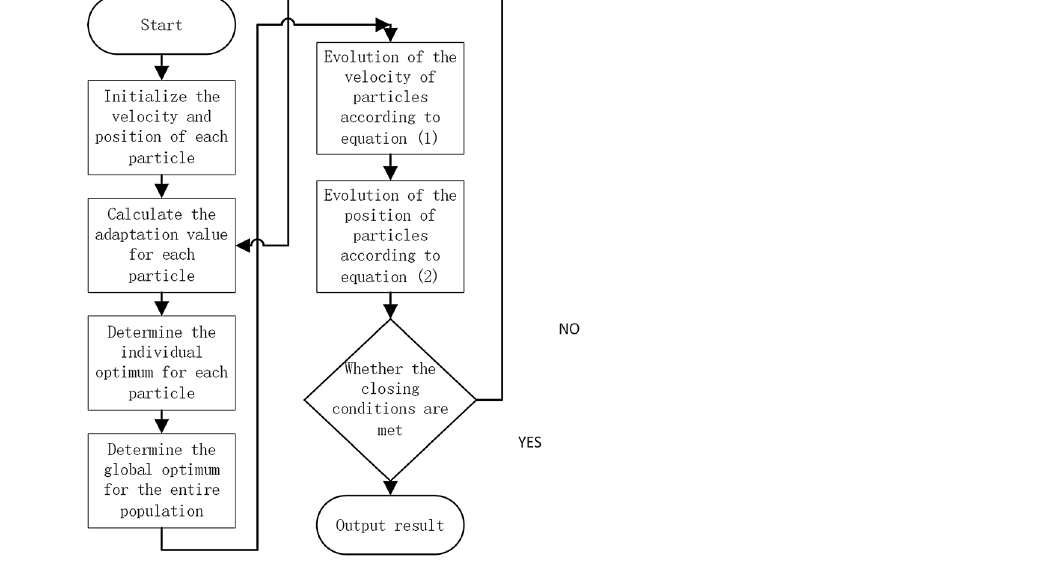
Figure 1. Flow chart of particle swarm